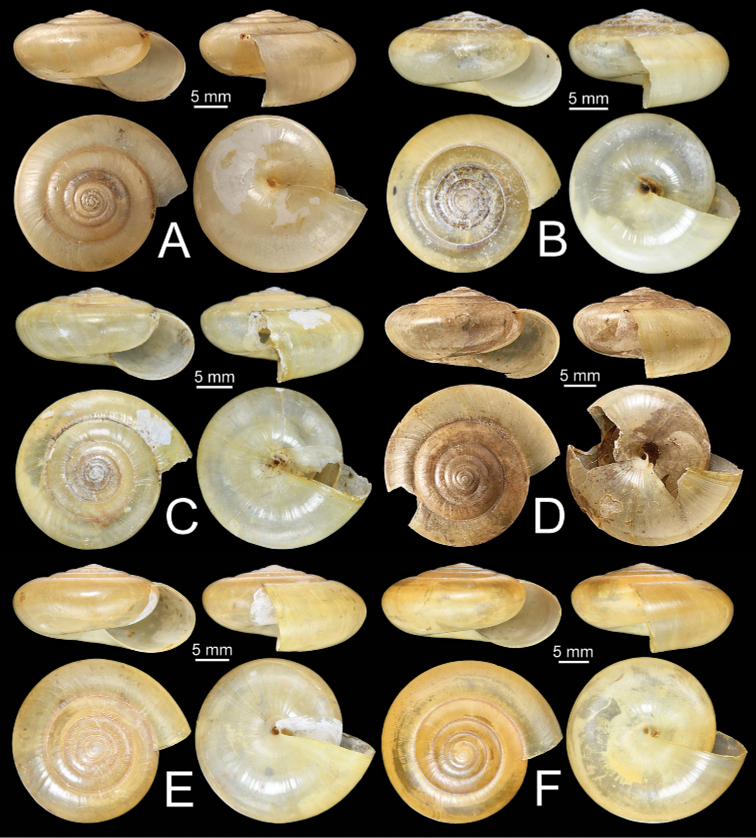
Shells of Group II: Sarika
hainesi group. A–CSarika
hainesiA syntype NHMUK 20200290 and B, C specimen CUMZ 7237 D–FS.
bocourtiD syntype NHMUK 1893.2.4.1076–1077 E specimen CUMZ 7590, and F specimen CUMZ 7592.